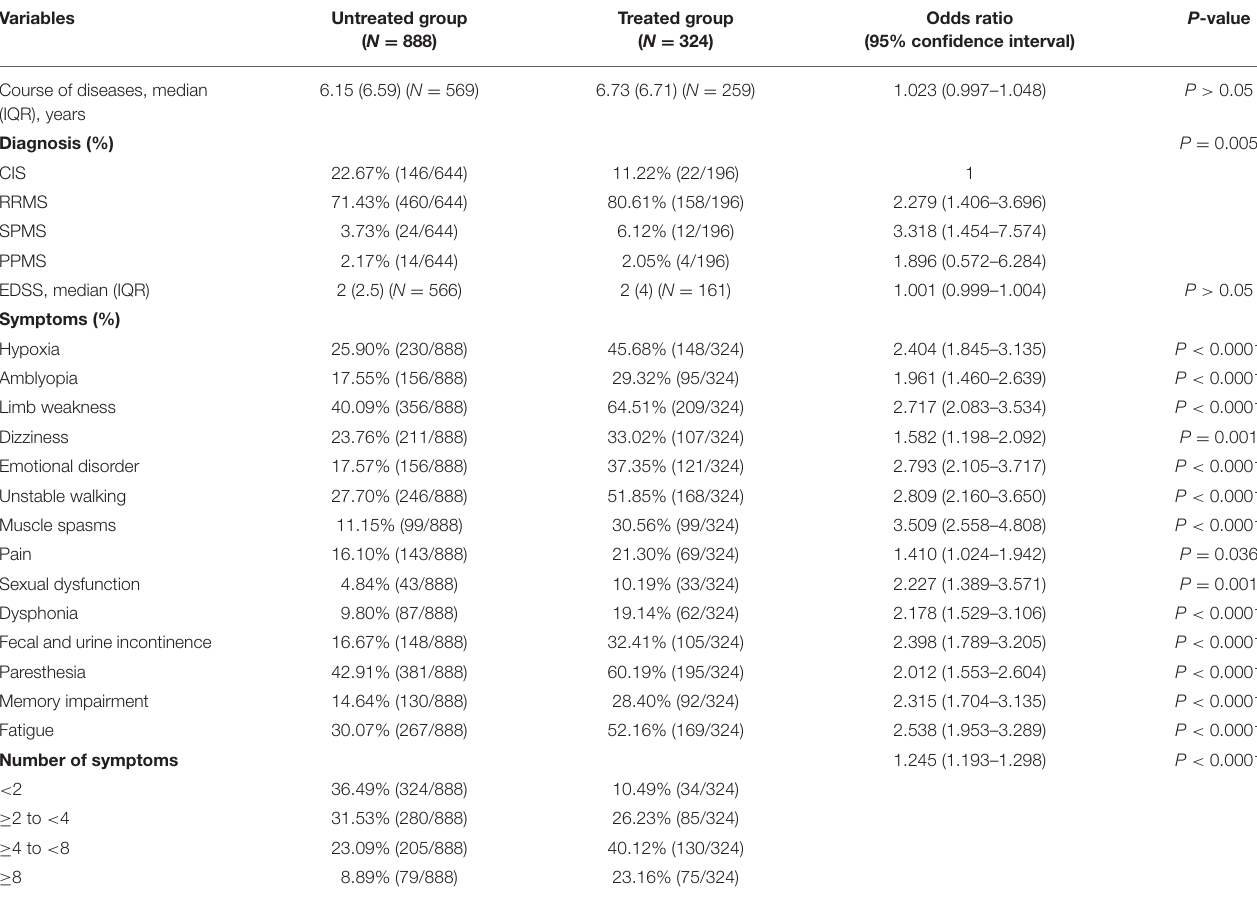
TABLE 2 | Disease characteristics in the treated group and untreated group.